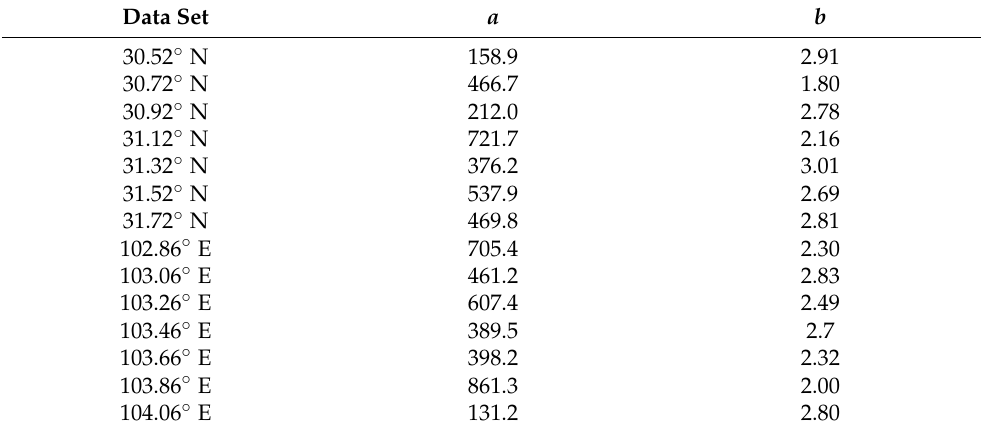
Table 1. Parameters of the least squares fit relation S = a λ b , for fourteen terrain height variance spectra of 30 (cid:48)(cid:48) resolution (R1) for the landslide-prone areas in western Sichuan. Data Set